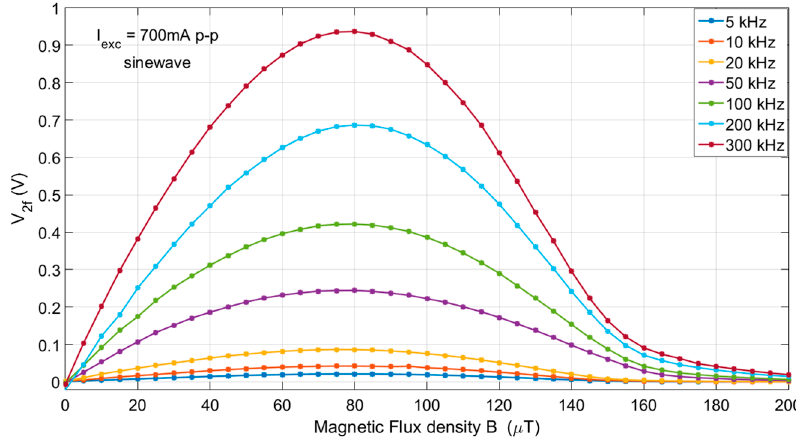
Figure 3. Second harmonic sensor response to applied field for various excitation frequencies.